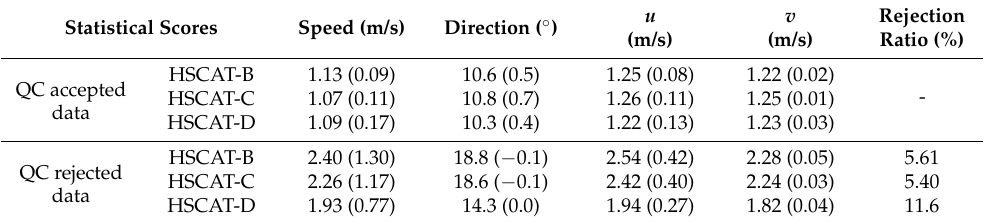
Table 4. The same as Table 2 (w.r.t. ECMWF), but using the above new QC. Statistical Scores Speed (m/s)